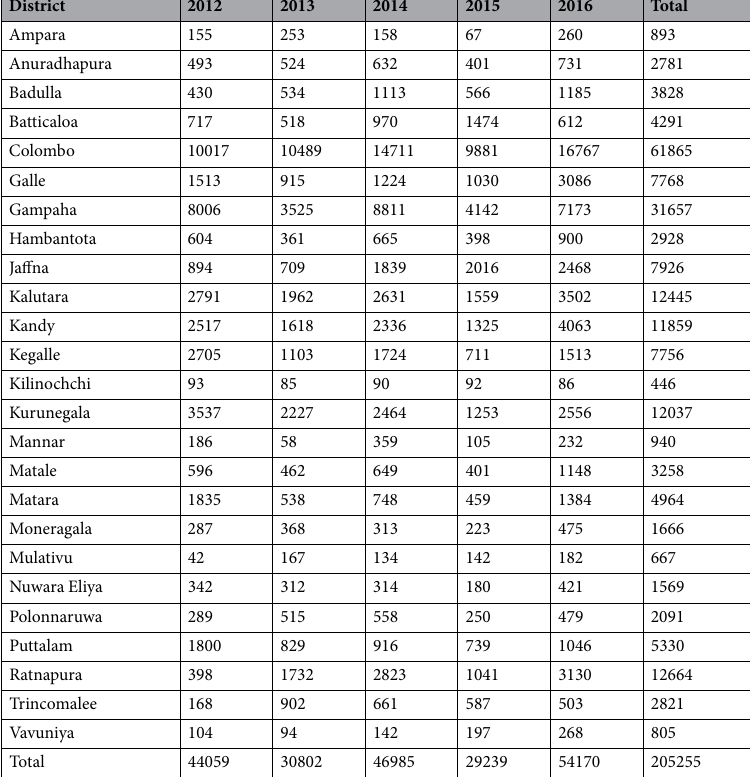
Table 1. The number of dengue cases for each district of Sri Lanka for 2012 to 2016 collected from Epidemiology Unit of Sri Lanka 36